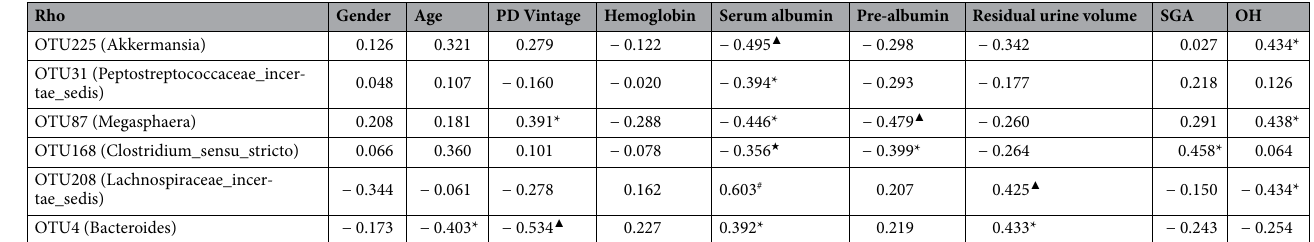
Table 3. Correlations of abundant bacteria on OTU level with clinical parameters in the whole group of 30 CAPD patients. PD peritoneal dialysis, SGA subjective global assessment, OH overhydration. * P < 0.05, ★ P = 0.05, ▲ P < 0.01, # P <